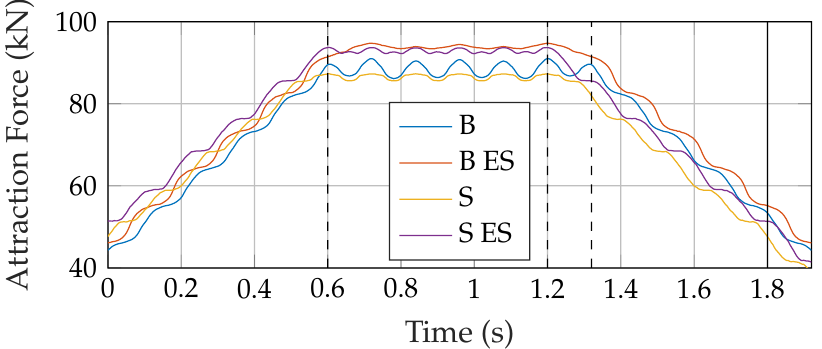
Figure 17. Attraction force for buried (B) and surface-mounted (S) PMs with and without extended stator (ES). Full stator overlap is from t = 0.6 s to t = 1.32 s and t = 1.2 s for buried and surface topologies, respectively, indicated by the dashed vertical lines. The far right vertical line indicate 50% active stator area for the surface-mounted topology.